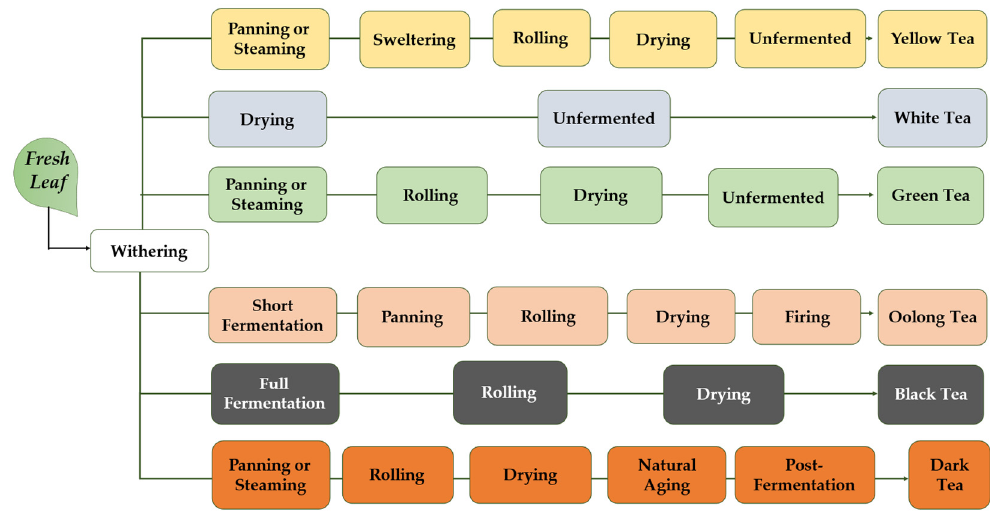
Figure 1. Tea processing technologies